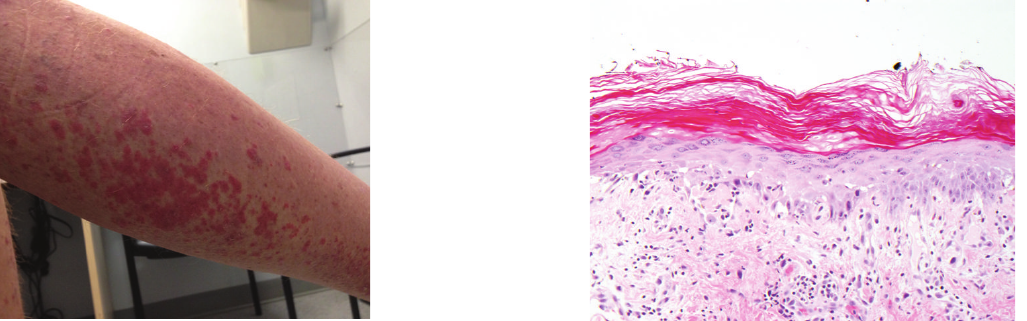
Figure 3: Figure showing skin biopsy of the lesion. Vacuolar alter- ation of the basal layer and numerous clumped cytoid bodies along the dermoepidermal junction and focally within the spinous layer, stratum corneum, and superficial adnexal epithelium are seen. Within the dermis, there is a superficial and mid perivascular and focally perifollicular inflammatory infiltrate comprised predomi- nantly of lymphocytes with scattered melanophages. Neutrophils and eosinophils are not